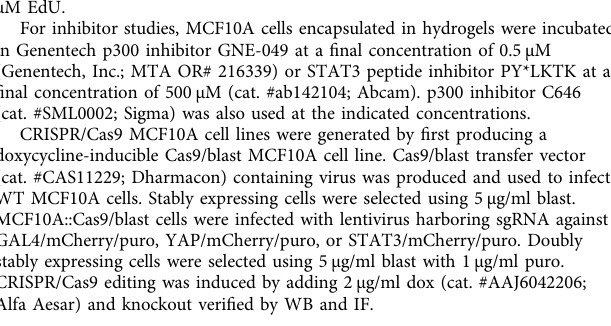
Reagents . EdU incorporation assay (cat. #C10337; Thermo Fisher Scienti fi c) was performed according to manufacturer ’ s instructions with a 24 h incubation of 10 µM EdU. For inhibitor studies, MCF10A cells encapsulated in hydrogels were incubated in Genentech p300 inhibitor GNE-049 at a fi nal concentration of 0.5 µM (Genentech, Inc.; MTA OR# 216339) or STAT3 peptide inhibitor PY*LKTK at a fi nal concentration of 500 µM (cat. #ab142104; Abcam). p300 inhibitor C646 (cat. #SML0002; Sigma) was also used at the indicated concentrations. CRISPR/Cas9 MCF10A cell lines were generated by fi rst producing a